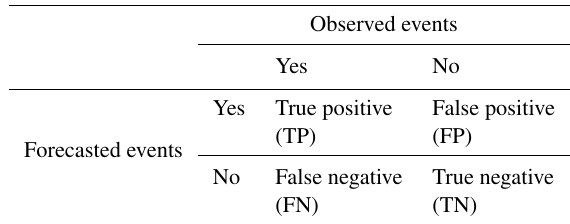
Table 6. Contingency matrix for the validation of landslide early warning model. True positive (TP), true negative (TN), false posi- tive (FP) and false negative (FN).